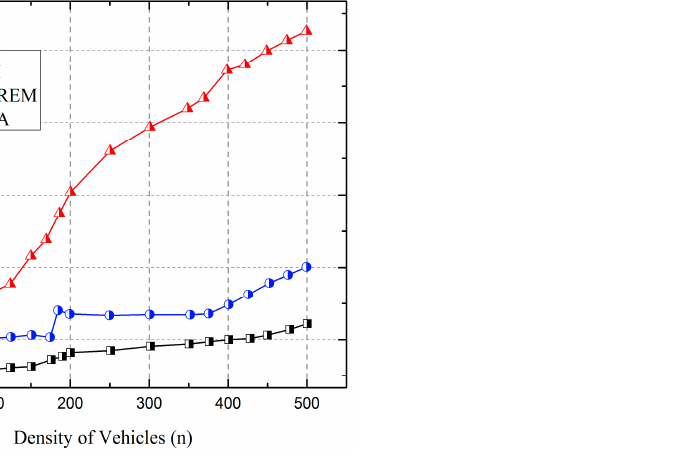
Figure 6. Analysis of transmission delay in transmitting alert messages with high density of vehicles.